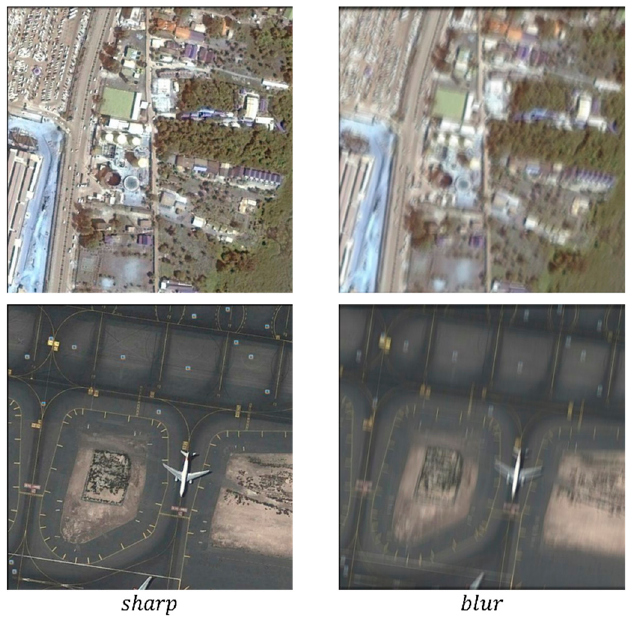
Figure 6. Example graph of RSDATA dataset.